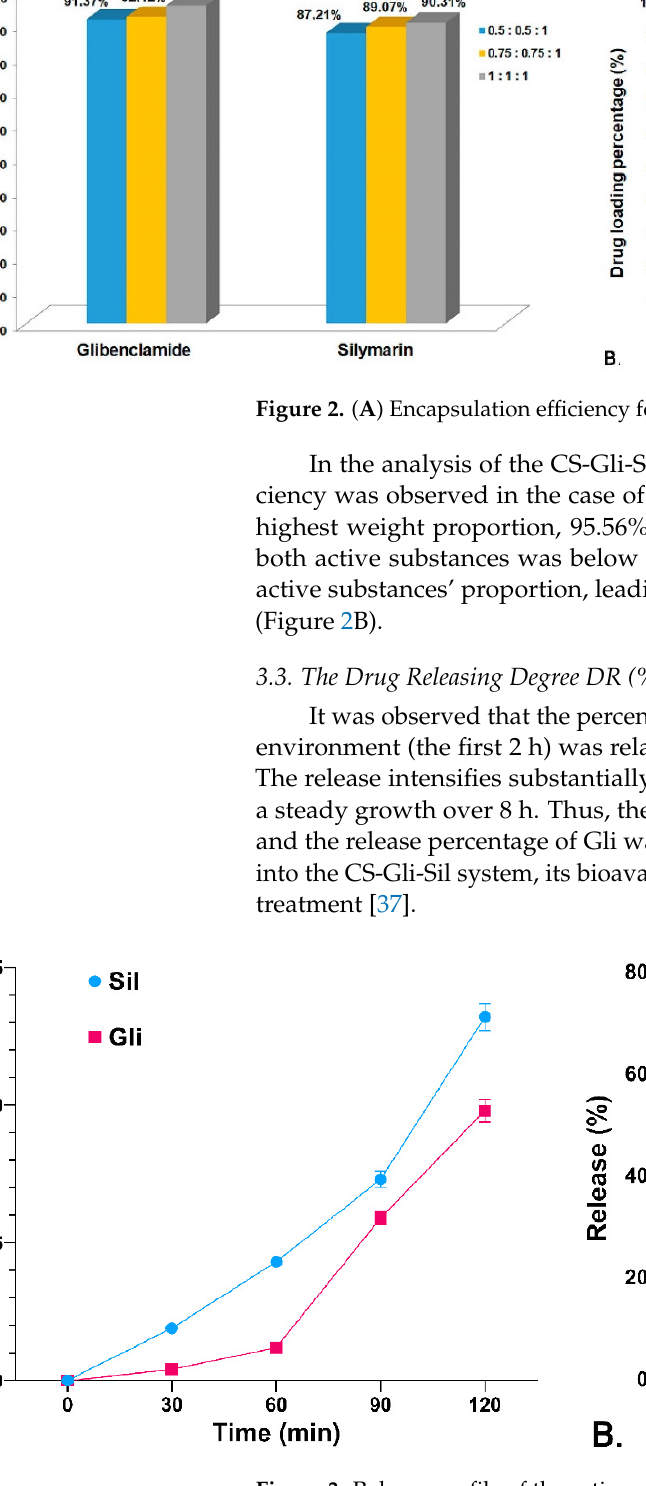
Figure 3. Release profile of the active substances (%) from the CS-Gli-Sil system: ( A ) in simulated gastric fluid; ( B ) in simulated intestinal fluid. gastric fluid; ( B ) in simulated intestinal